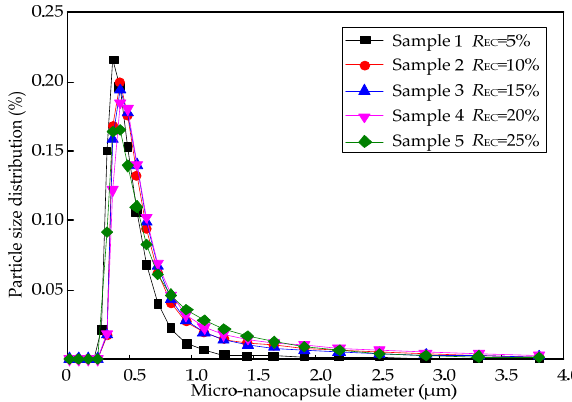
Figure 7. Particle size distribution of micro ‐ nanocapsules prepared by different amounts of emulsifier.